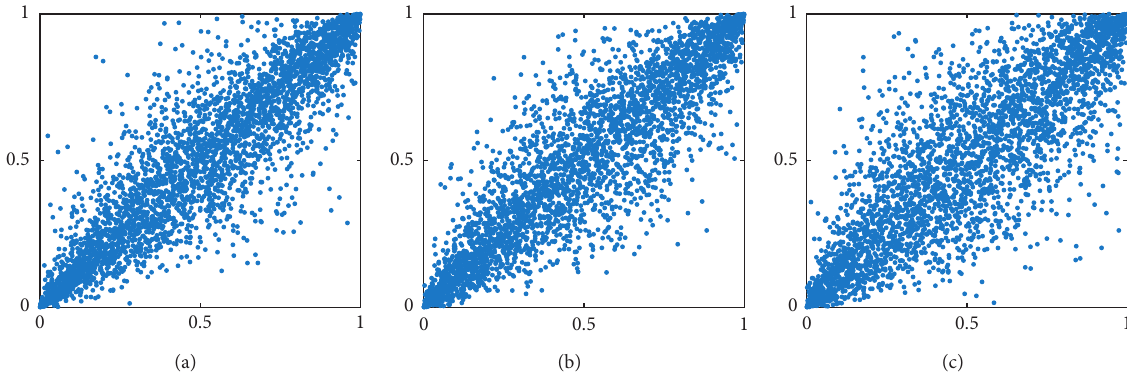
Figure 7: Bivariate scatter plots of uniform scores. (a) HSI-CEI. (b) HSI-CCI. (c) CEI-CCI.